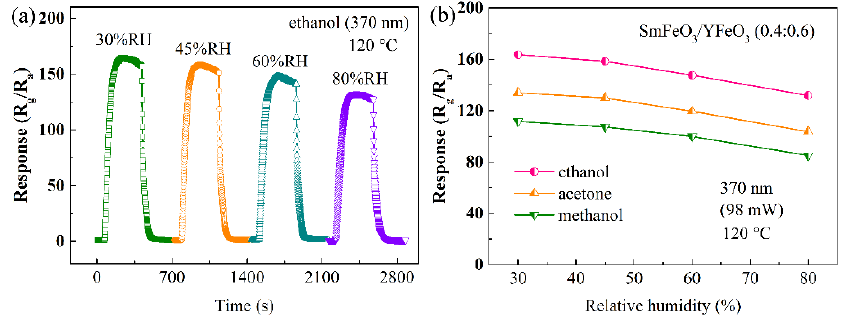
Figure 11. ( a ) Dynamic-response curve under different humidity levels of the SmFeO 3 /YFeO 3 (0.4:0.6) sensor for ethanol gas; ( b ) variation curves with humidity of the SmFeO 3 /YFeO 3 (0.4:0.6) sensor for VOC gases under 370 nm of light illumination.